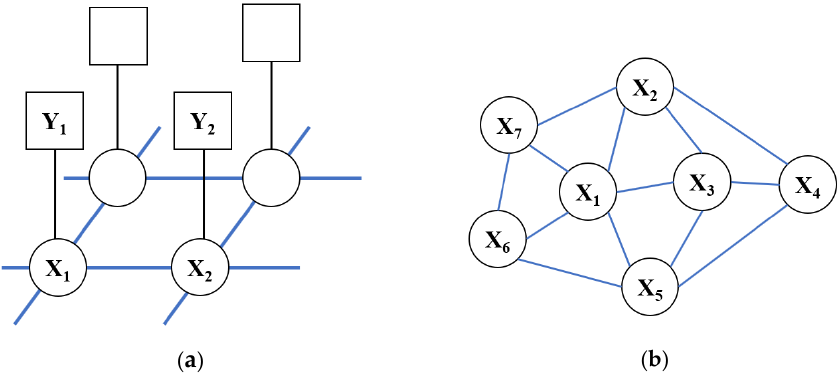
Figure 5. Different types of MRF models. ( a ) Structure of the classical MRF model; ( b ) Structure of the RAG MRF model.